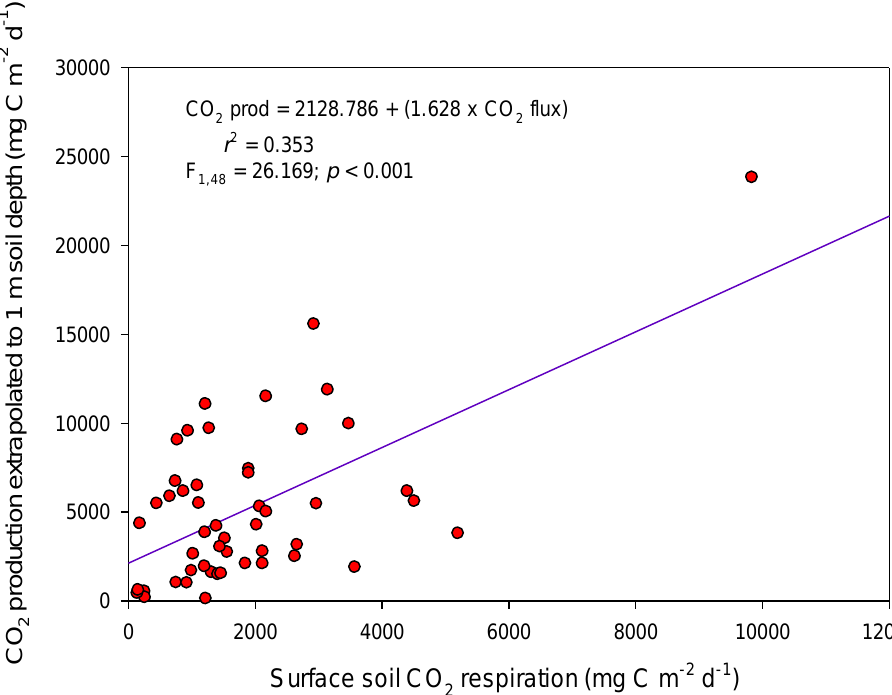
Figure 3. The relationship between surface soil CO 2 respiration and DIC production extrapolated to a soil depth of 1 m (see text for explanation) in mangrove forests across several locations worldwide. The regression equation and coefficient are significant for n = 50 total measurements.